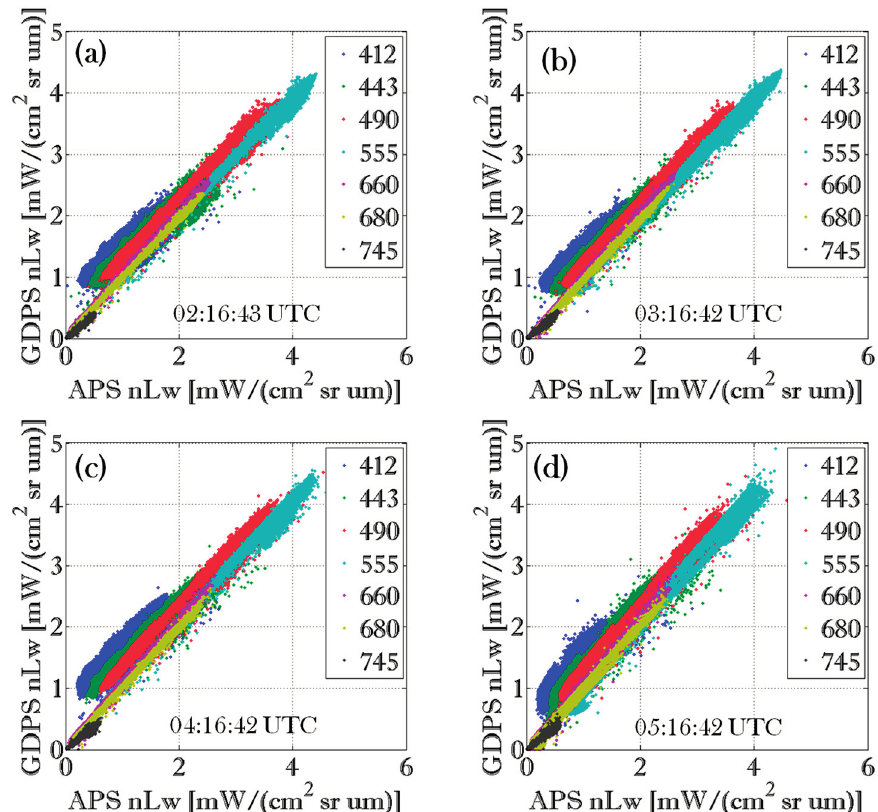
Figure 3. Scatterplots between APS and GDPS datasets from 5 April 2011 for all GOCI ocean color bands including NIR: ( a ) for the image acquired at 02:16:43 UTC; ( b ) for the image acquired at 03:16:42 UTC; ( c ) for the image acquired at 04:16:42 UTC; and ( d ) for the image acquired at 05:16:42